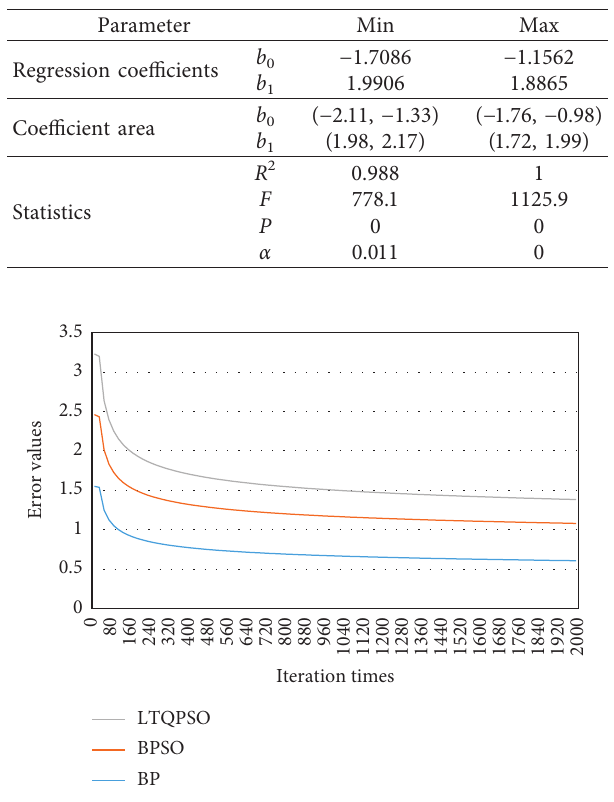
Figure 5: Error curve of particle swarm optimization